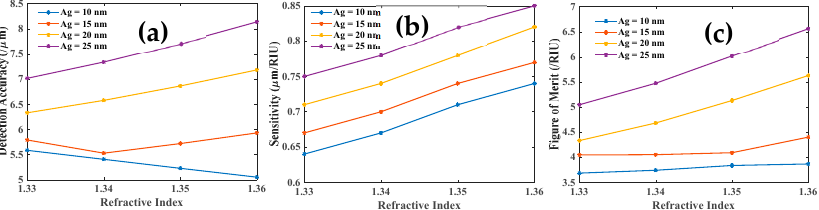
Figure 14. ( a ) DA, ( b ) sensitivity, and ( c ) FOM of the first LMR dip as a function of RI of the ana-